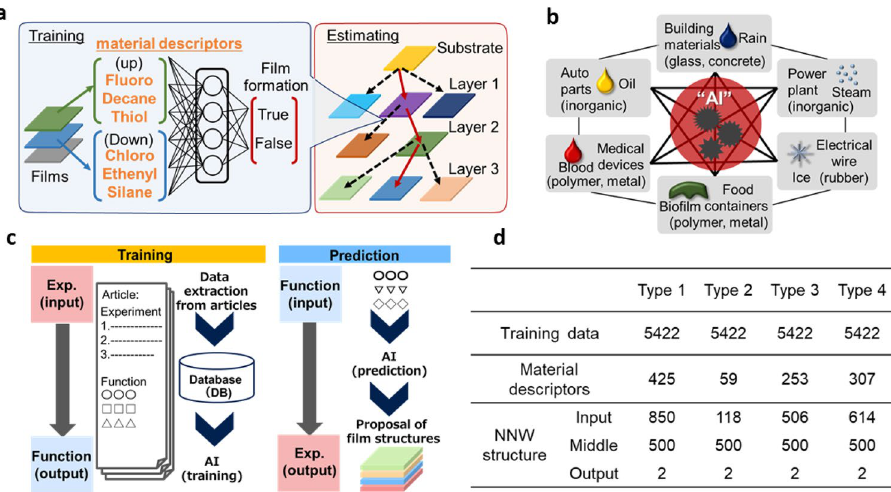
Figure. 1. Machine learning method for multilayer functional films. ( a ) Starting from substrate, CNNWs estimate upper layer’s material on down layer, and this procedure is repeated until the end of outermost surface. ( b ) Strongly connect scientific knowledge such as antifouling films with different specialties. ( c ) Whole system for learning and inference. d, Summary of training datasets and NNW